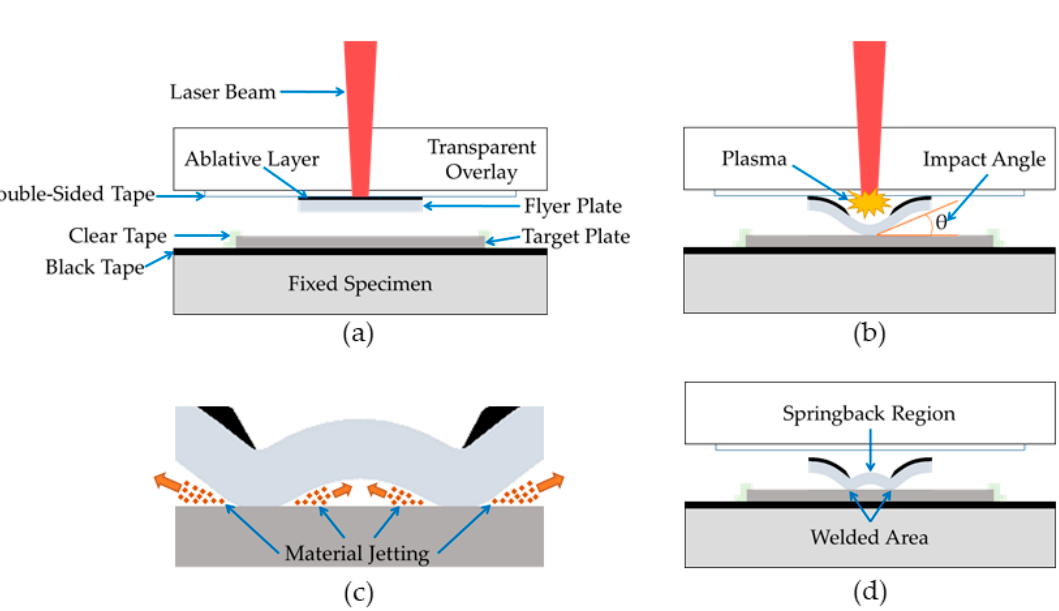
Figure 1. Schematic of the LIW setup and different stages of the experiment: ( a ) LIW components; ( b ) Laser impact; ( c ) Material jetting in the impact region; ( d ) Springback region and welded area. Note: Spacers are not shown.